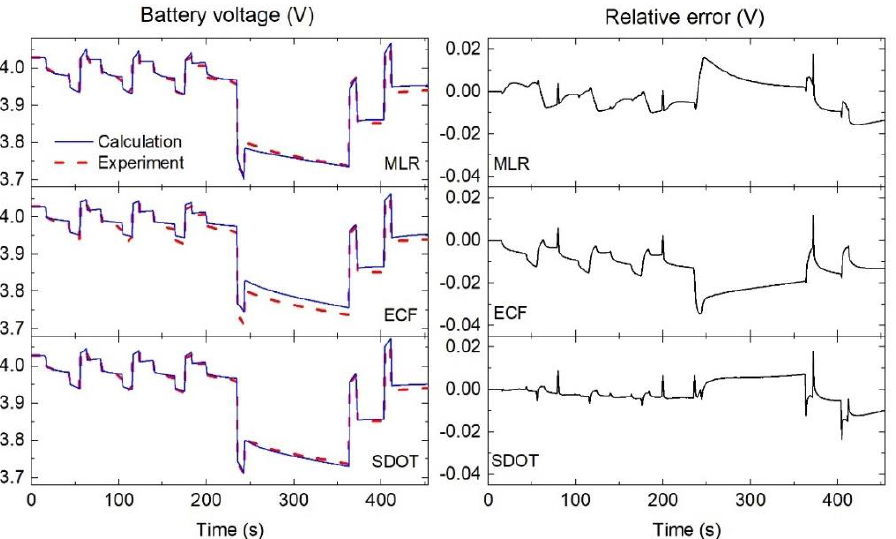
Figure 12. The battery terminal voltage of the ISO dynamic test and the relative error for the three estimations.